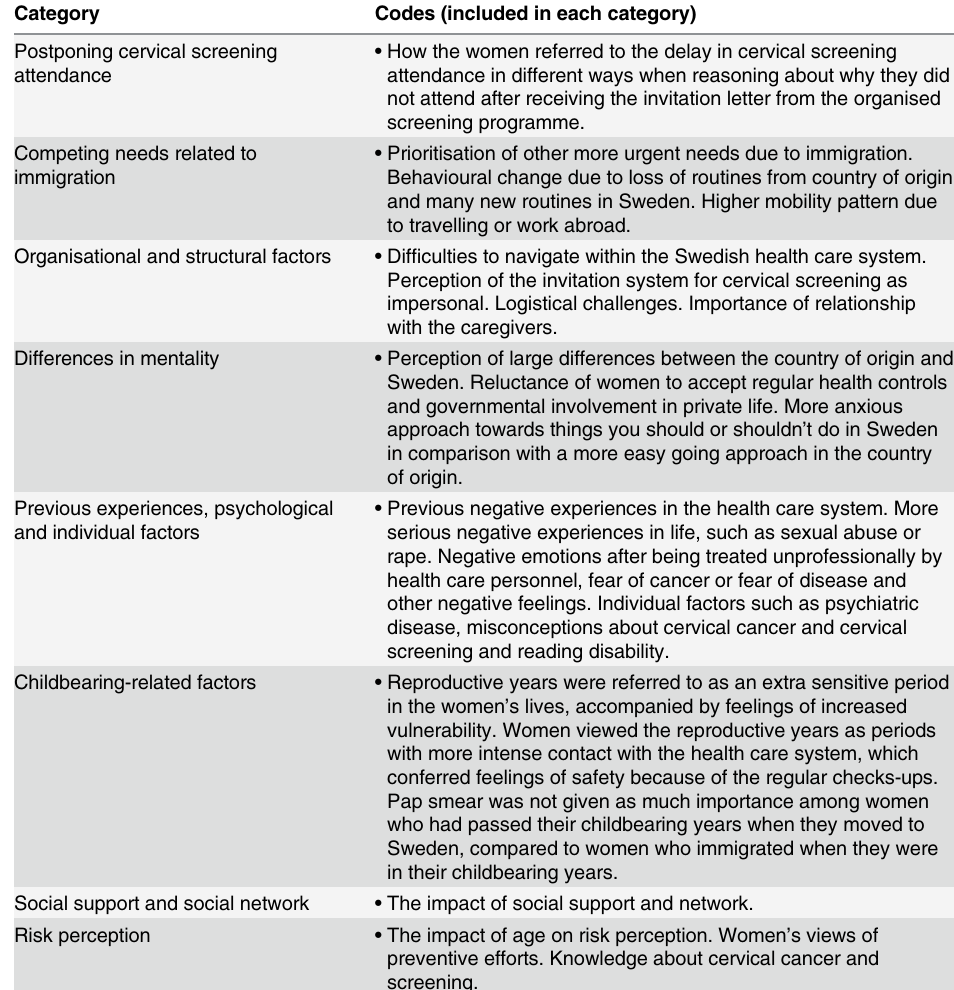
Table 4. Description of the codes and categories generating the main theme: “ Women have a compre- hensive rationale for postponing cervical screening, yet do not view themselves as non-attenders ” . Category Codes (included in each category) Postponing cervical screening